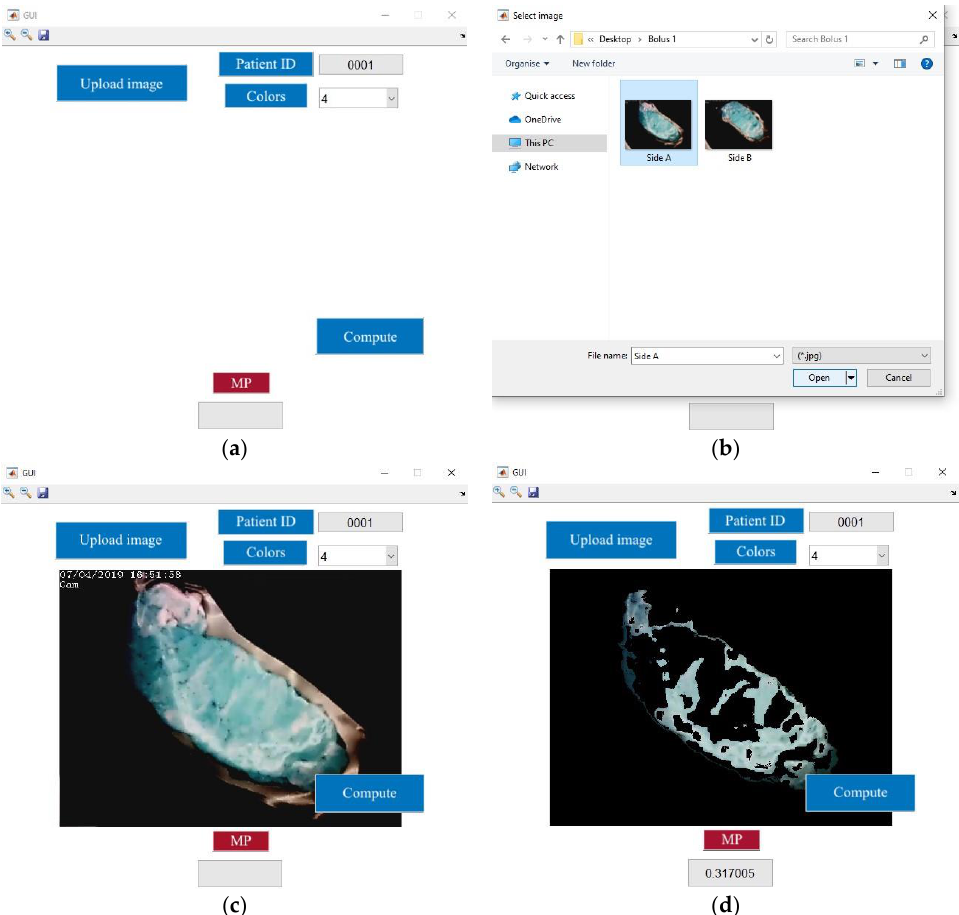
Figure 3. Digital analysis of the samples: ( a ) first view of the scene; ( b ) the user has to upload the image for analysis (one side of the bolus per time); ( c ) once the image is uploaded, it is ready to be analyzed; ( d ) the software automatically analyzes the image and gives as output the percentage of the mixed portion of the sample.